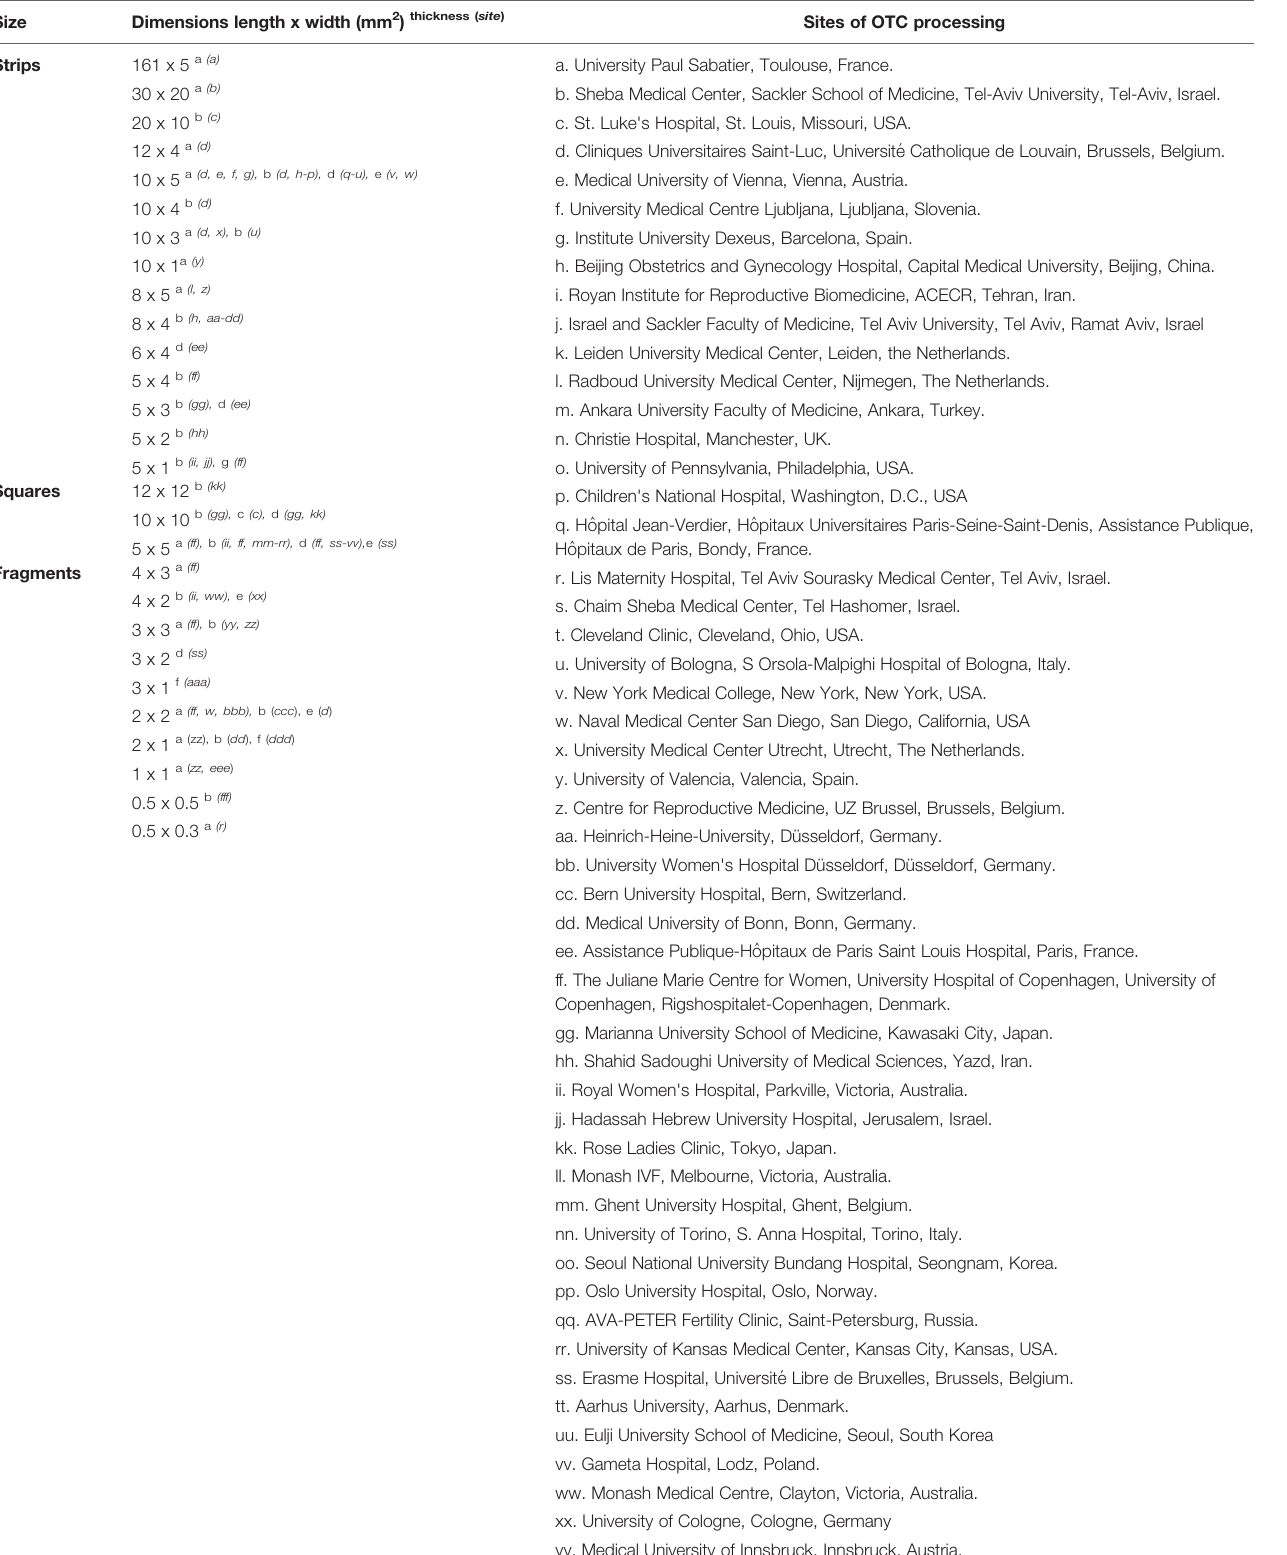
TABLE 1 | Ovarian tissue cryopreservation processing sizes across different sites around the world.